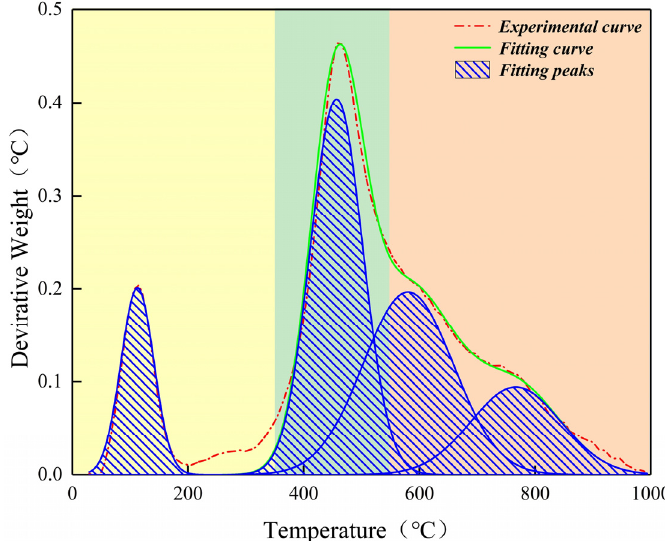
Figure 2. Peak fitting of DTG curve.